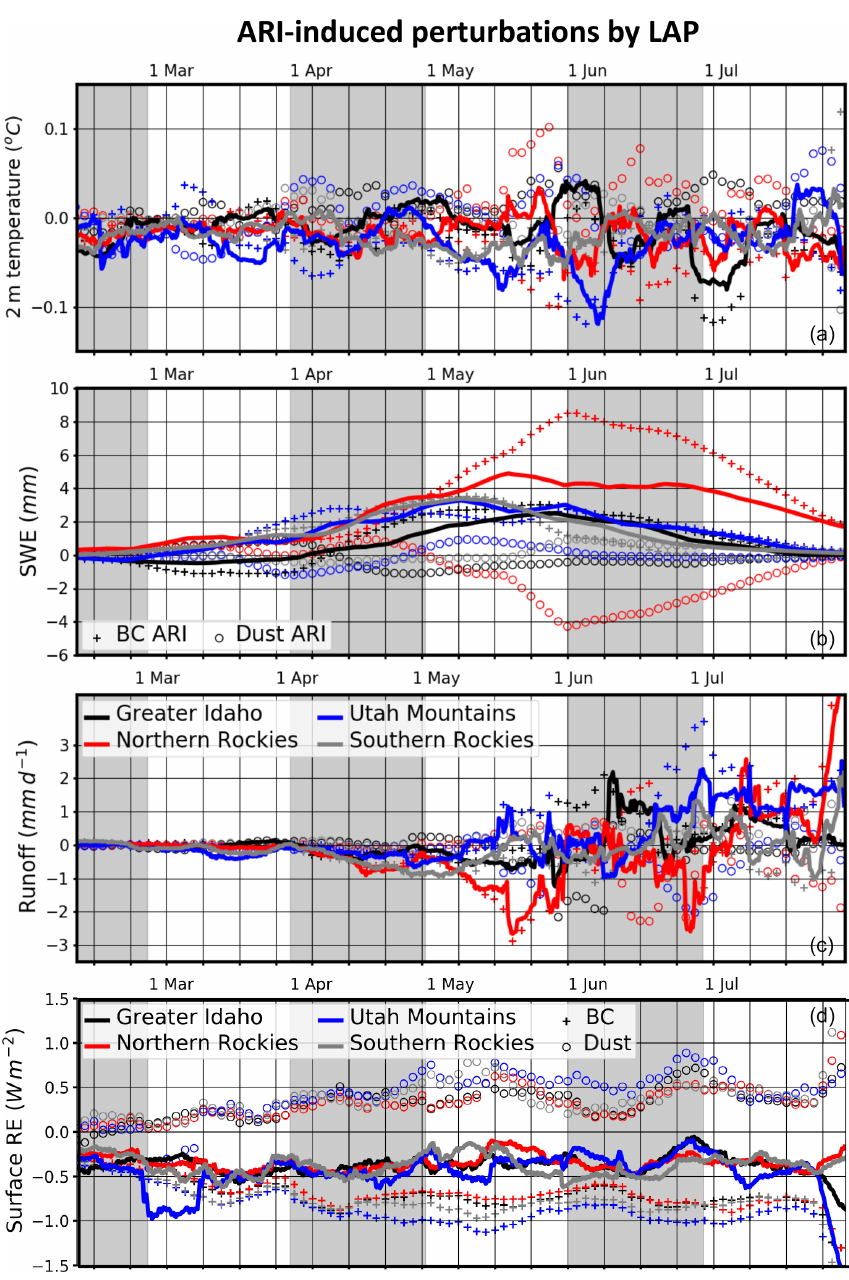
Figure 11. Same as in Fig. 9 but for ARI-induced perturbations. Additionally, panels (c) and (d) show ARI-induced perturbations in runoff and the surface energy budget. Crosses in panel (c) show BC-induced perturbations to the surface energy budget, while hollow circles show dust-induced